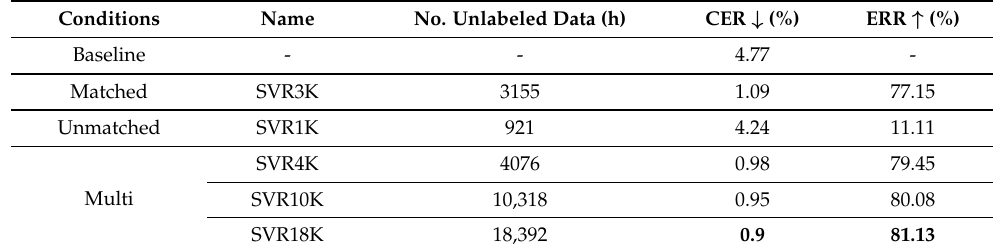
Table 7. The ASR results of KForeignWordSpeech (3155 h) for the four conditions trained with the whole dataset as the supervised data. Bold indicates the best